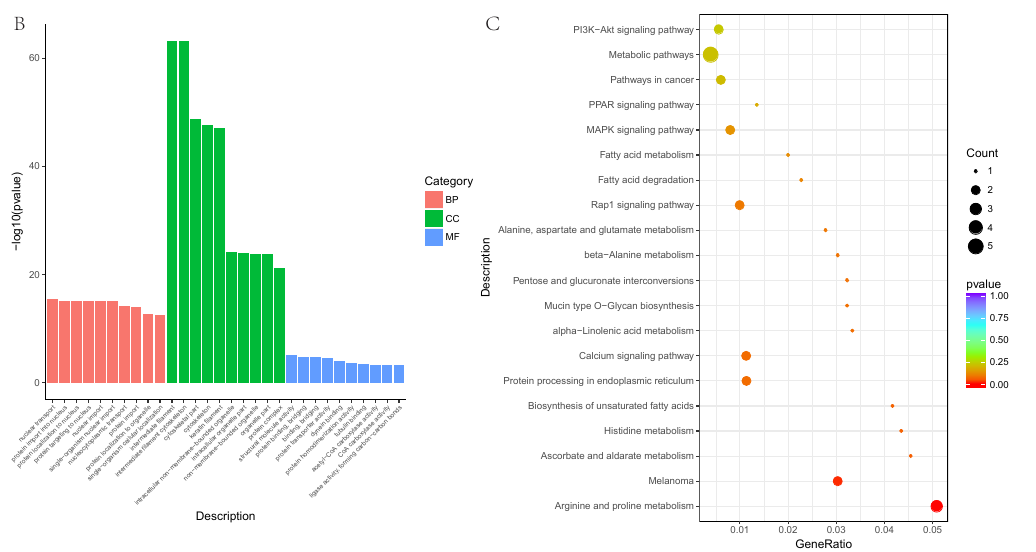
Figure 4. Magenta module function analysis. ( A ) Heatmap of the magenta module’s gene expres- sion patterns, ( B ) GO analysis of the magenta module, and ( C ) KEGG enrichment analysis of the magenta module.